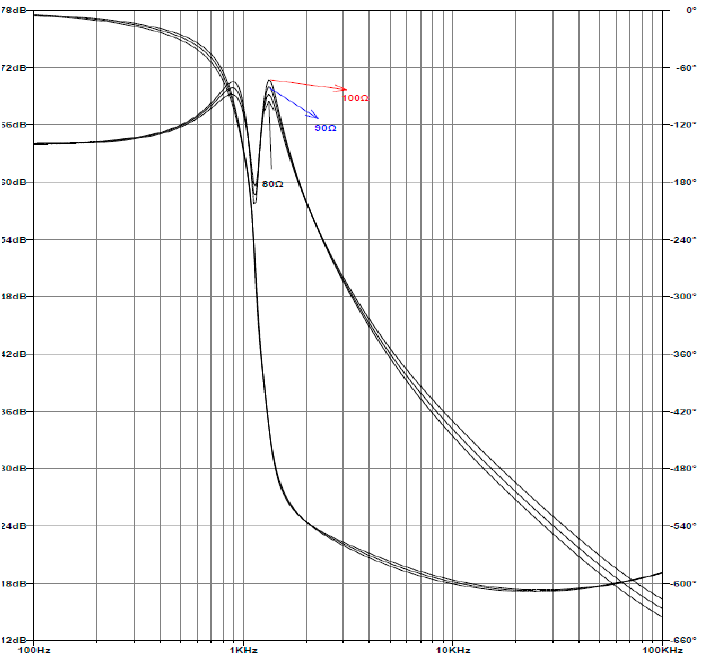
Figure 14. G vd for SEPIC for fixed R.